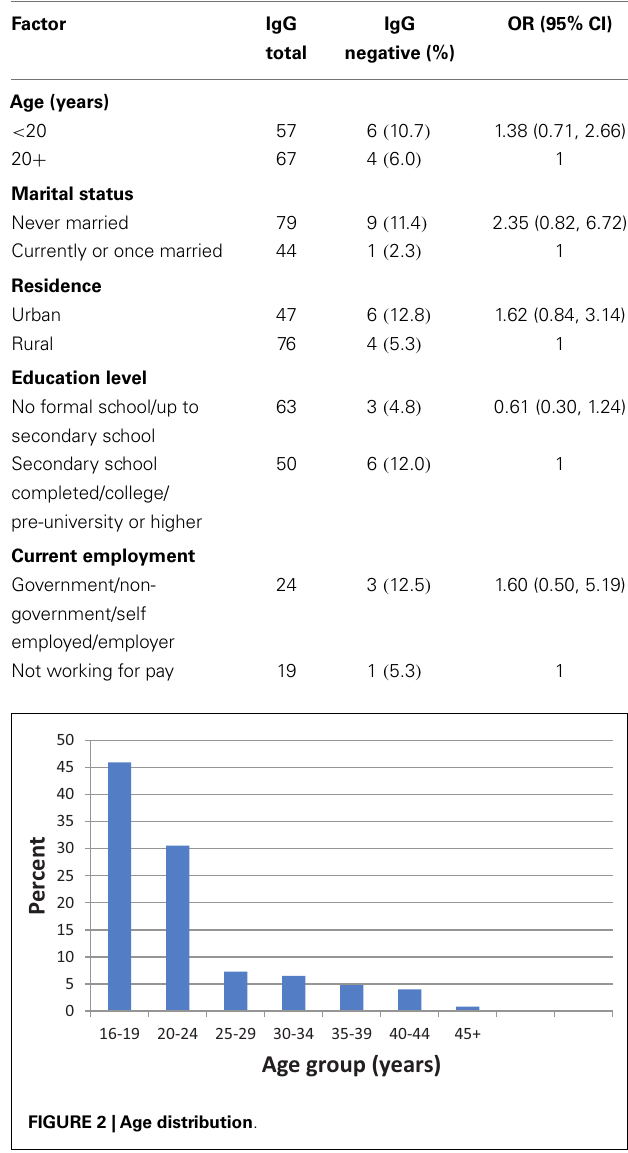
Table 2 | Factors associated with rubella seronegativity .